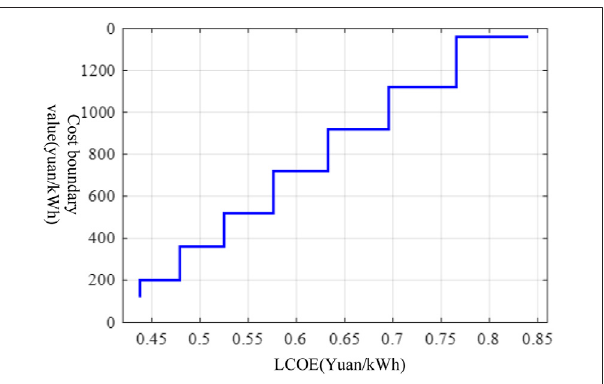
FIGURE 8 | Payback boundary value.